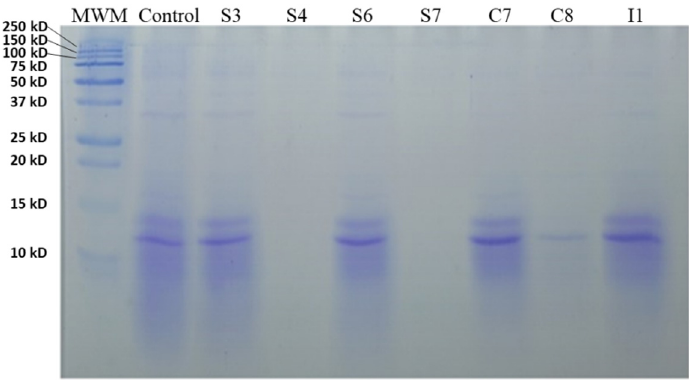
Figure 1. SDS-PAGE analysis of fermented waste broth with 2% glucose with different isolated bacteria; MWM, molecular weight marker.